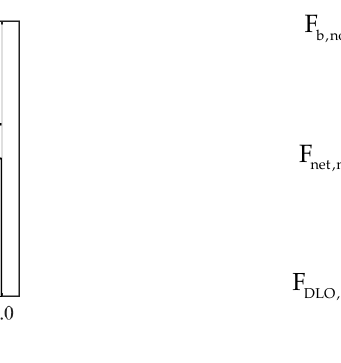
Figure 19. Normalization of the loads from codes, literature, and DLO.